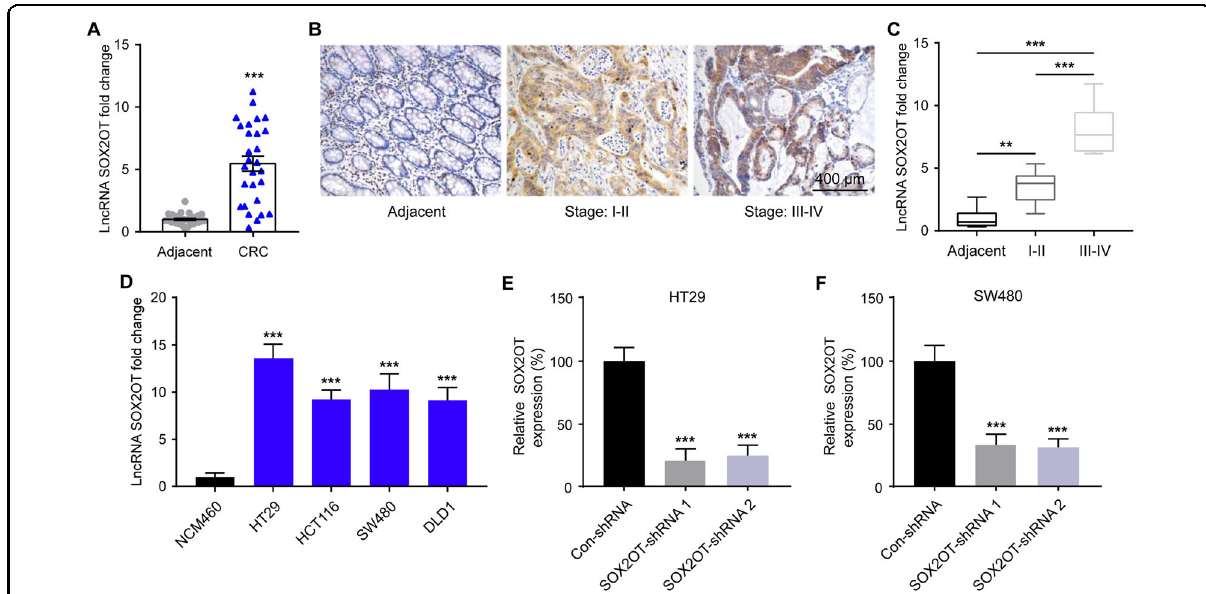
Fig. 1 LncRNA SOX2OT expression was upregulated in CRC. A qRT-PCR showing the expression level of SOX2OT in CRC tissues and adjacent non-tumor tissues, *** P < 0.001. B Representative IHC images of staining of SOX2OT in different TNM stages in tumor and adjacent non-tumor tissues respectively, scale bar = 400 μ m. C qRT-PCR showing the expression level of SOX2OT in different TNM stages, ** P < 0.01, *** P < 0.001 vs. adjacent. D qRT-PCR showing the expression level of SOX2OT in CRC cell lines, *** P < 0.001 vs. NCM460. E , F shRNAs were used to knock down SOX2OT in HT29 and SW480 cells, *** P < 0.001 vs. Con-shRNA. Data were expressed as mean ± SD. All experiments were repeated three